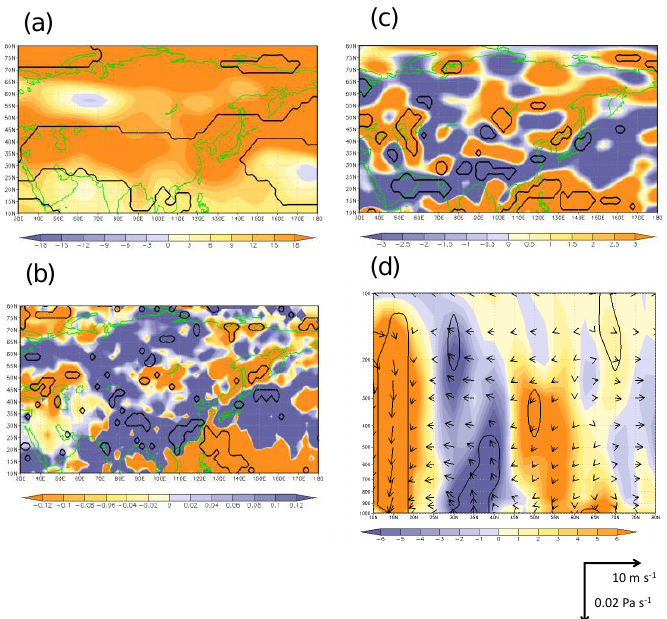
Figure 8. Composite differences in ( a ) geopotential height (in m) at 500 hPa, ( b ) precipitation (in mm day −1 ), and ( c ) vertical p-velocity (in 10 −3 Pa s −1 ) at 500 hPa between hot and cool summer years in SIS. ( d ) Latitude-pressure cross-section of the composite differences in vertical p-velocity (in 10 −3 Pa s −1 ) between hot and cool summer years in SIS at 140° E. Vectors show the composite differences in meridional-vertical flow (see legend for units). The borders of regions that reached a significance of 95% are shown with thick